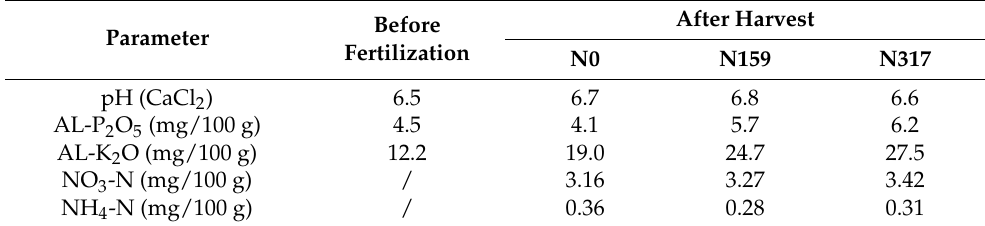
Table 3. Soil properties before fertilization and after the Chinese cabbage harvest.